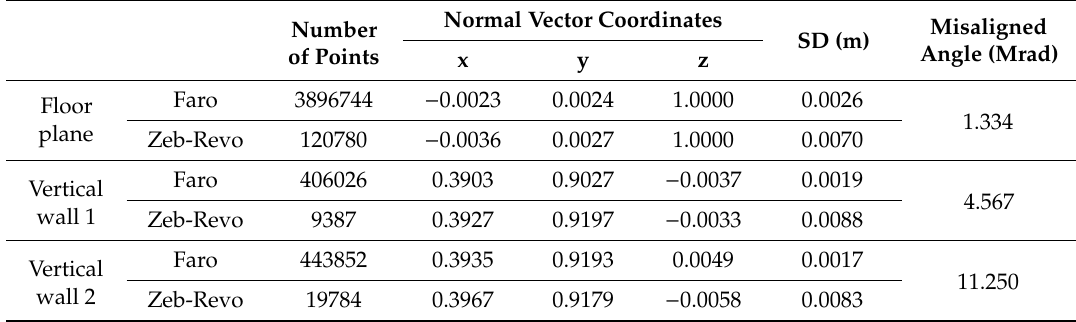
Table 6. Results of the fitting for the vertical planes (walls) and horizontal plane (roof) from point clouds regions (Figure 6).